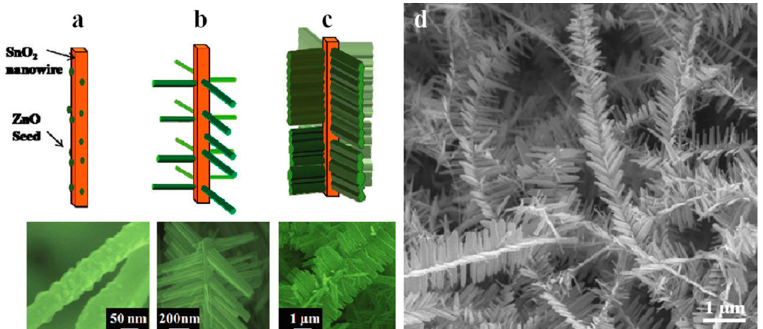
Figure 10. ( a–c ) Growth process of the SnO 2 /ZnO hierarchical nanostructures. Top row: schematics. Bottom row: corresponding SEM images of the product. ( d ) SEM image of the SnO 2 /ZnO hierarchical nanostructures (Reproduced with permission from [107], Copyright 2009, American Chemical Society).